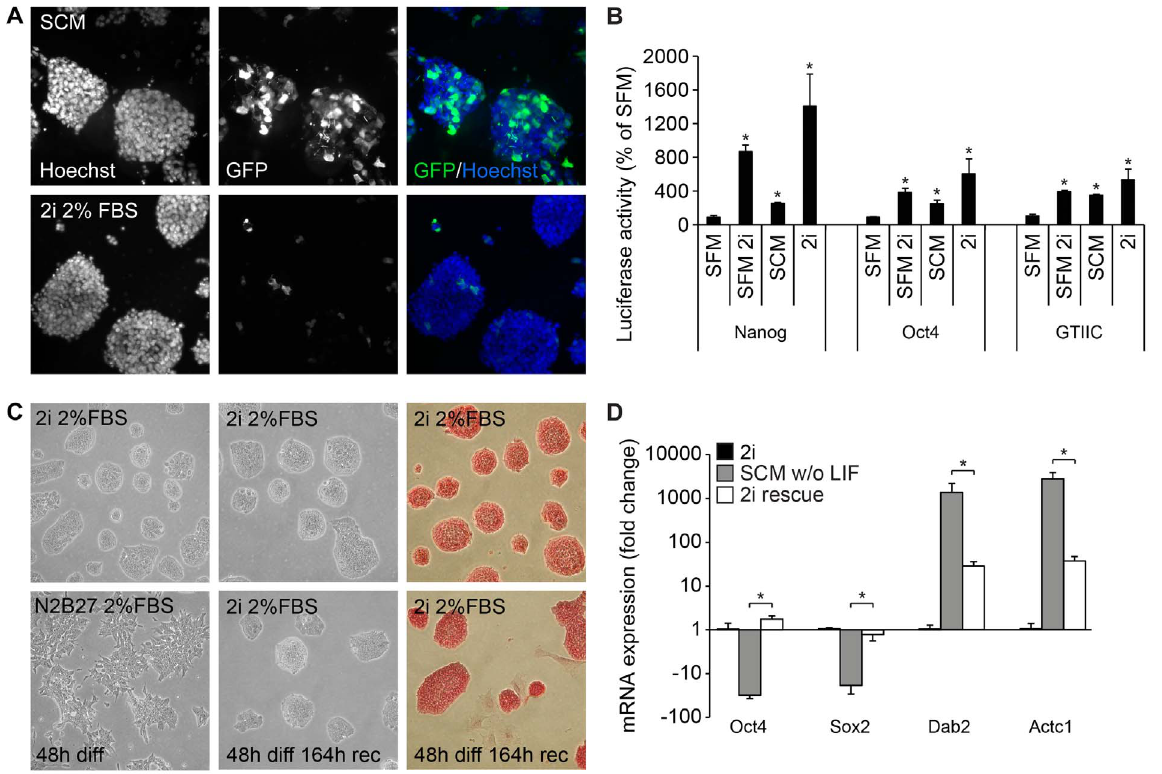
Figure 5. Characterisation of mouse ES cells cultured in 2i media. Fluorescence micrographs of GFP-expression E14 mES cells, pre- transfection cultured in 2i or SCM, transfected with Lipofectamine 2000 and pmaxGFP (A). Luciferase reporter assay for Oct4 and Nanog promoter activation, as well as Tead-enhanced promoter activation, 24 hrs post-transfection in E14 cells cultured without LIF in serum-free SCM with or without PD0325901 (1 m M) and CH99021 (3 m M), SCM, or 2i media. Results are mean 6 sd (n=3) p(*) , 0.05 (B). Phase-contrast micrographs of colony morphology and alkaline phosphatase activity staining (C), and qPCR analysis (D) of E14 cell 96 hrs after 2i rescue and clean-up of partially differentiated mES cells cultures. 18S expression is used for normalization, and results are comparative (expression levels at passage 15 set as control) Ct value means 6 sd (n=3) p(*) , 0.05.